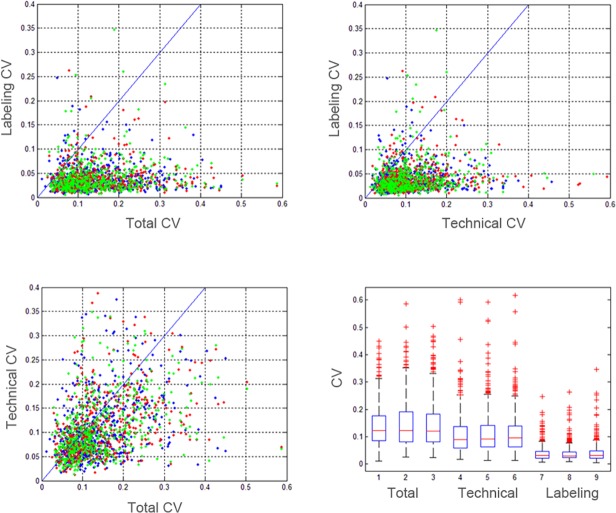
Comparison between total, technical and labeling CV of ‘core’ PBMC peptides.The peptides of the three replicates are represented in three different colors (red, green, blue). Most peptides have a lower labeling CV compared to both technical and total CVs. The comparison of technical CVs versus total CVs does indicate that some peptides show higher technical CVs compared to total CVs, indicating that technical issues contribute a substantial part to the total variation. The boxplot representation clearly demonstrates that higher median peptide CVs are present in the total CVs compared to technical CVs and labeling CVs.